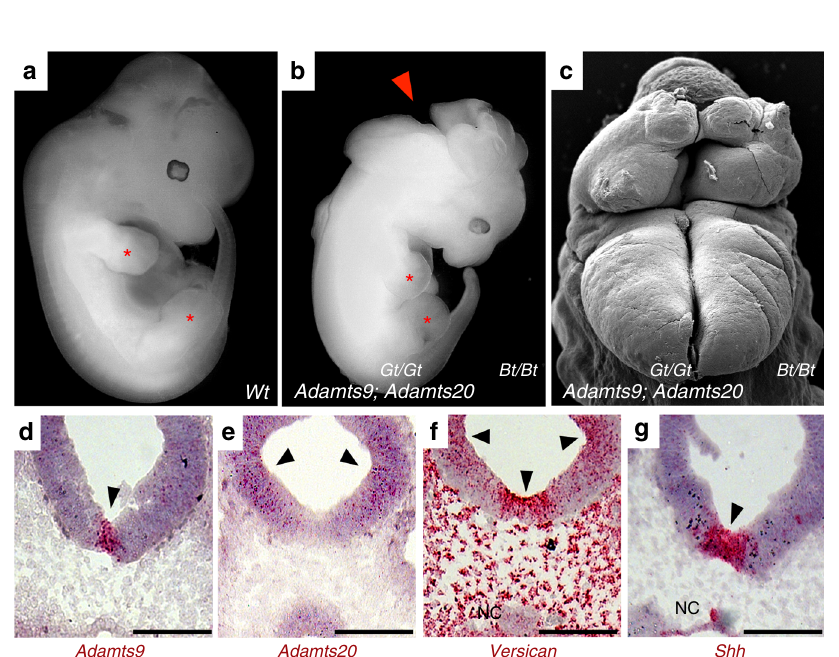
Fig. 5 Severe developmental defects resembling ciliopathies in Adamts9 Gt/Gt ; Adamts20 Bt/Bt mouse embryos. a E12.5 wild-type and Adamts9 Gt/Gt ; Adamts20 Bt/Bt embryos ( b ) showing occipital exencephaly (red arrowhead) and a malrotated body axis in the latter. Red asterisks indicate right-side limbs, which are abnormally close in the mutant ( b ). c Scanning electron micrograph of the exencephalic hindbrain of an E12.5 Adamts9 Gt/Gt ;Adamts20 Bt/Bt embryo. d – g RNAscope ® in situ hybridization shows expression domains of Adamts9 ( d ), Adamts20 ( e ), their cognate ECM substrate Vcan ( f ) and Shh ( g ) in the rostral neural epithelium of E9.5 embryos. Robust Adamts9 expression is observed in the rostral fl oor plate (arrowhead in d ) within the Shh expression domain (arrowhead in g ). Adamts20 is predominantly expressed in the lateral neural epithelium (arrowheads in e ). Vcan is strongly expressed in the fl oor plate and the lateral neural epithelium (lateral arrowheads in f ), with strong expression in surrounding craniofacial mesenchyme. NC, notochord. Scale bars = 100 μ m in d –